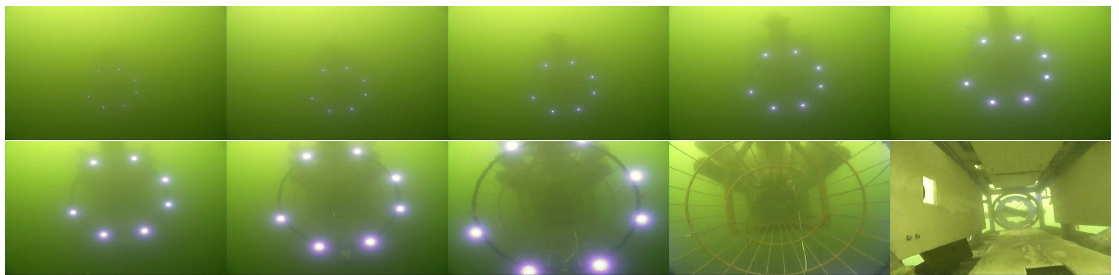
Figure 15. Images of the recycling process of Run 3.